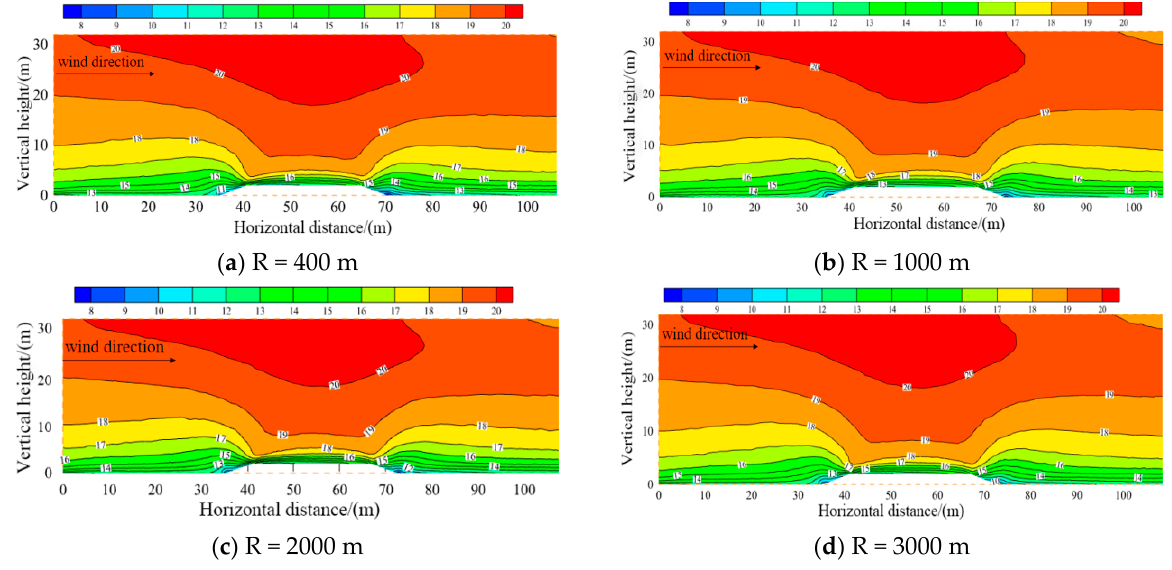
Figure 7. Flow-field distribution at the cross-section of the embankment on the convex side windward Y = 150 m.